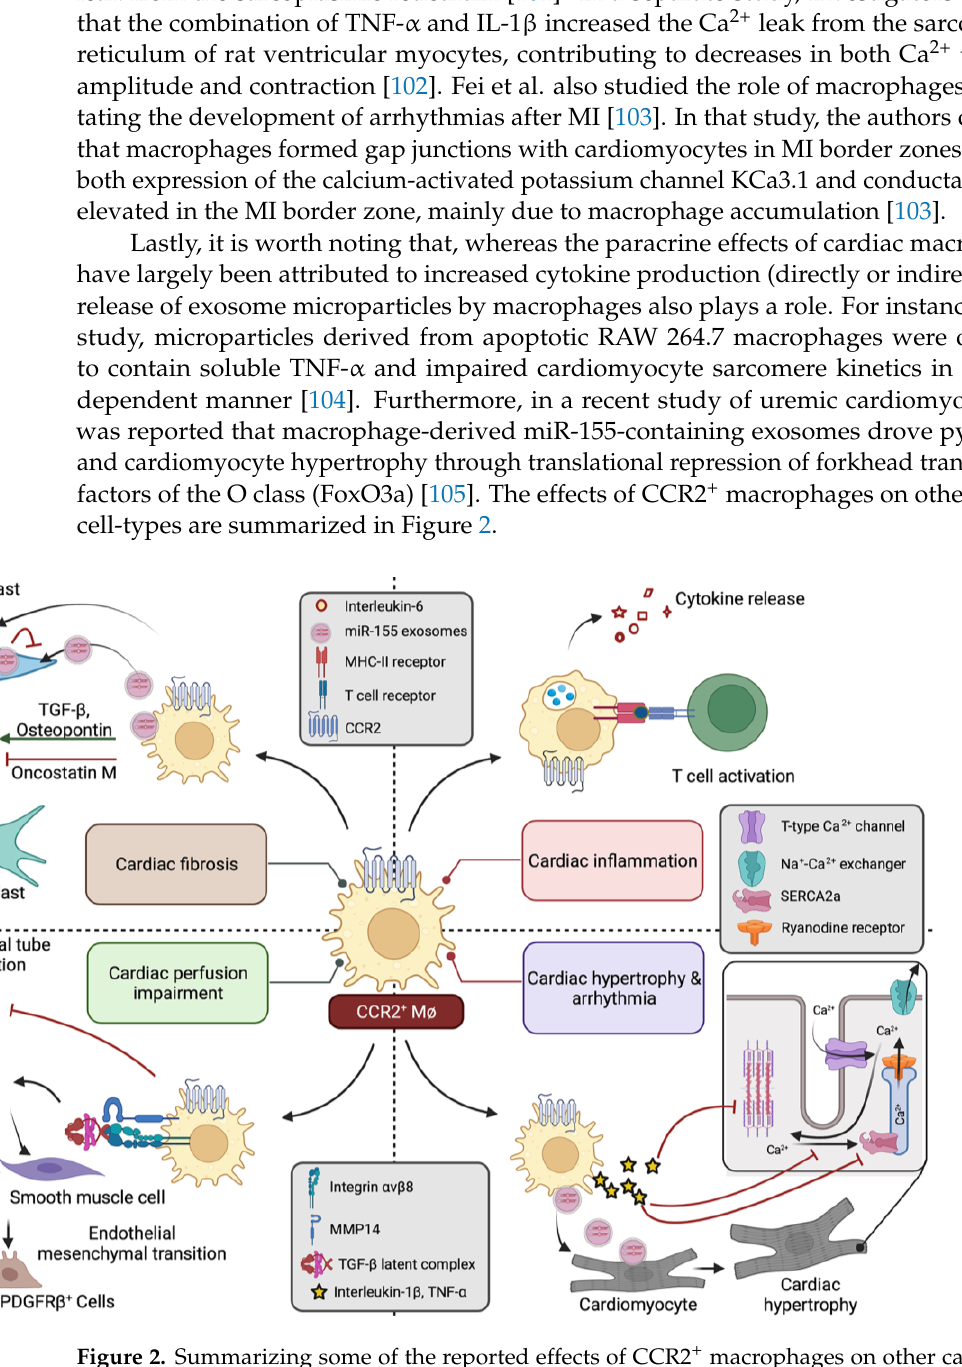
Figure 2. Summarizing some of the reported effects of CCR2 + macrophages on other cardiac cell- types. CCR2 + macrophages can activate T-cell-mediated immune responses through cardiac antigen presentation. The multiple cytokines secreted by CCR2 + cells can also cause cardiac inflammation. CCR2 + macrophages can also induce cardiac fibrosis and myofibroblast activation through the secretion of TGF- β and osteopontin. They can also induce fibroblast-mediated IL-6 secretion and autocrine activation of fibroblast proliferation. Other reports have suggested that proinflammatory macrophages can have opposing effects on fibroblasts, for instance, through